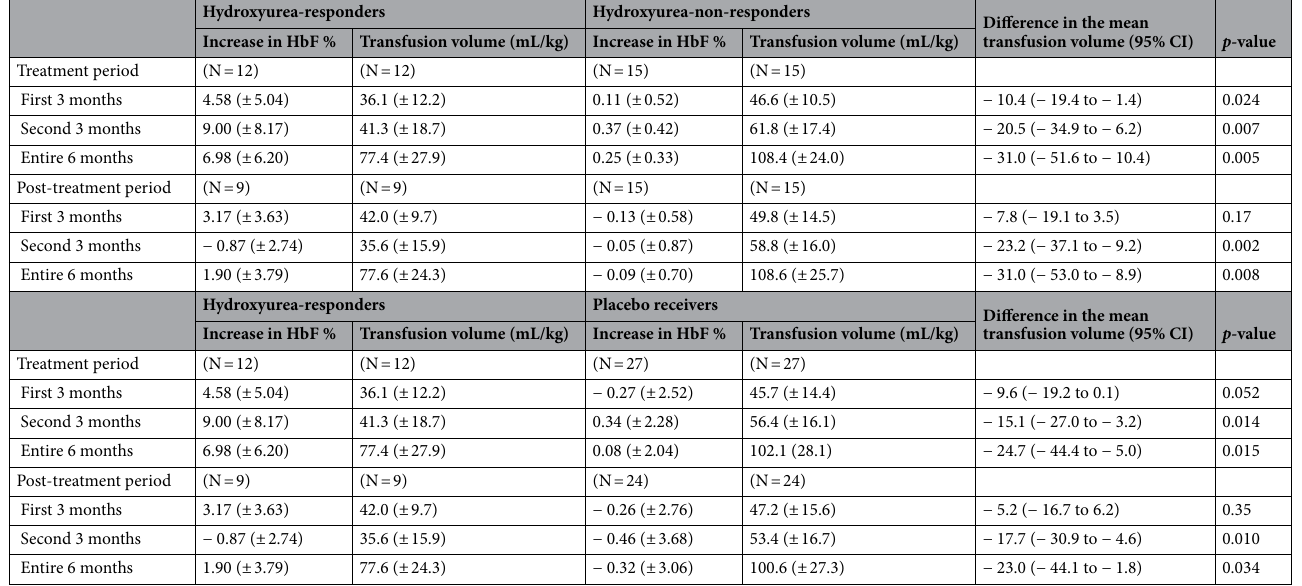
Table 5. Blood transfusion volume (mL/kg) received by hydroxyurea-responders, hydroxyurea- non- responders and placebo receivers. Data are mean (±